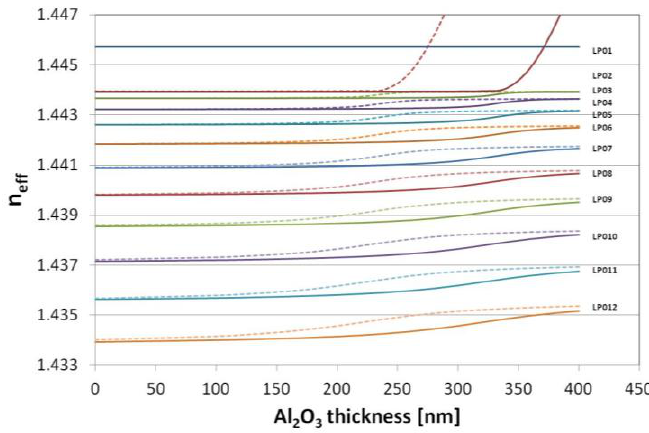
Figure 4. Simulated variation of the effective refractive index at λ = 1,550 nm of the modes LP to LP when n was 1 (solid lines) and 1.318 01 012 ext